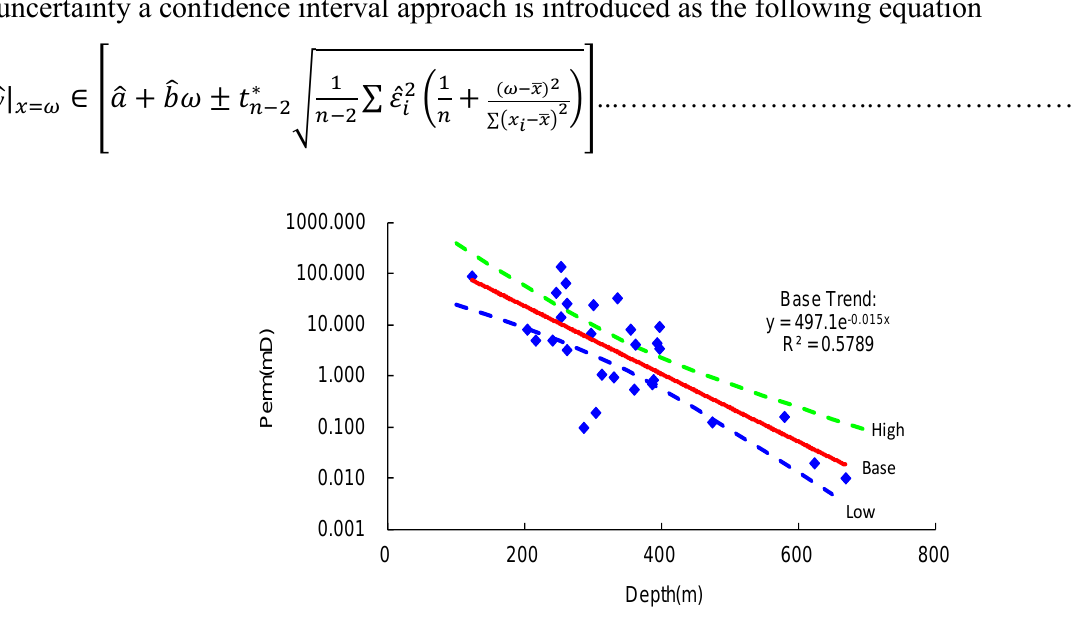
Figure 4—Permeability uncertainty